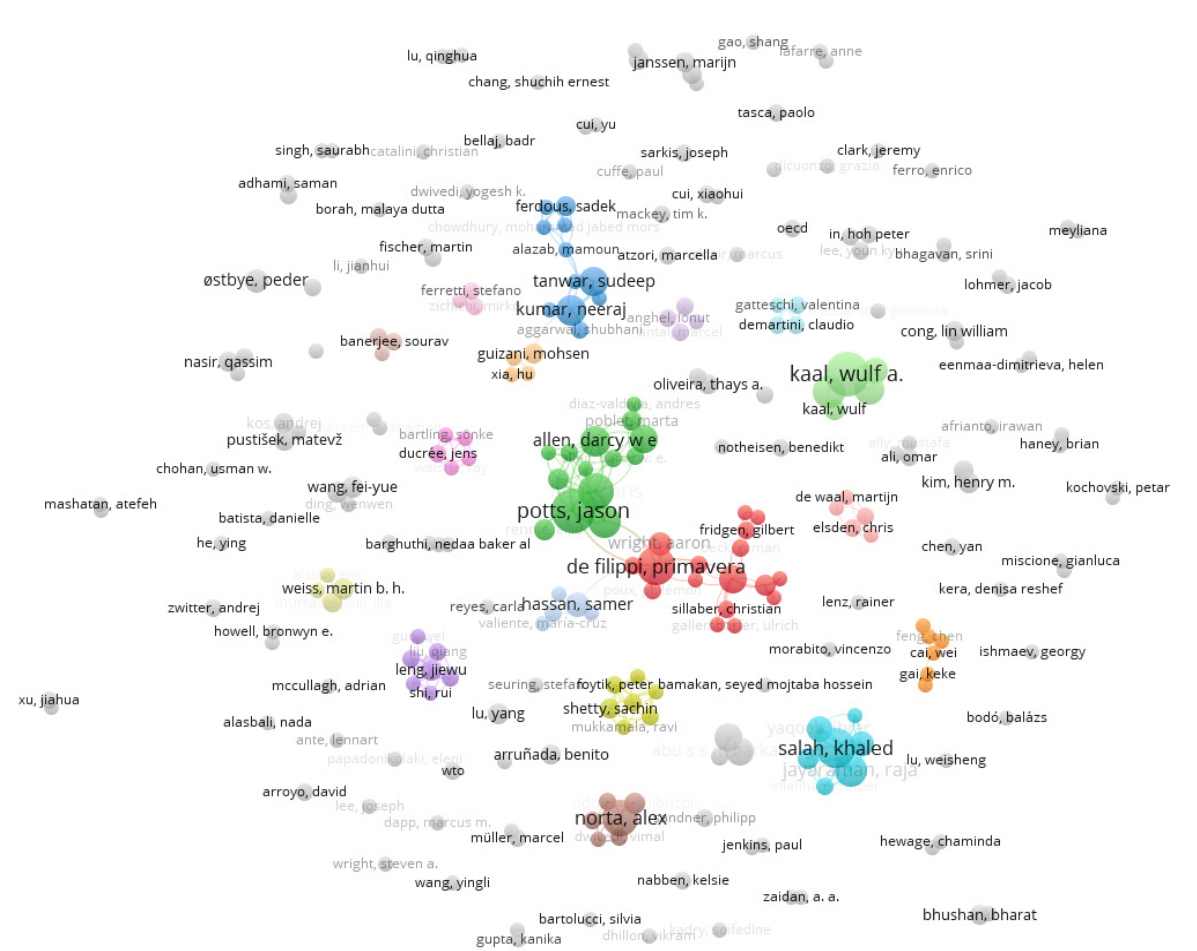
Figure 1. VOSviewer mapping of blockchain technology and smart contracts in decentralized governance systems regarding co-authorship.